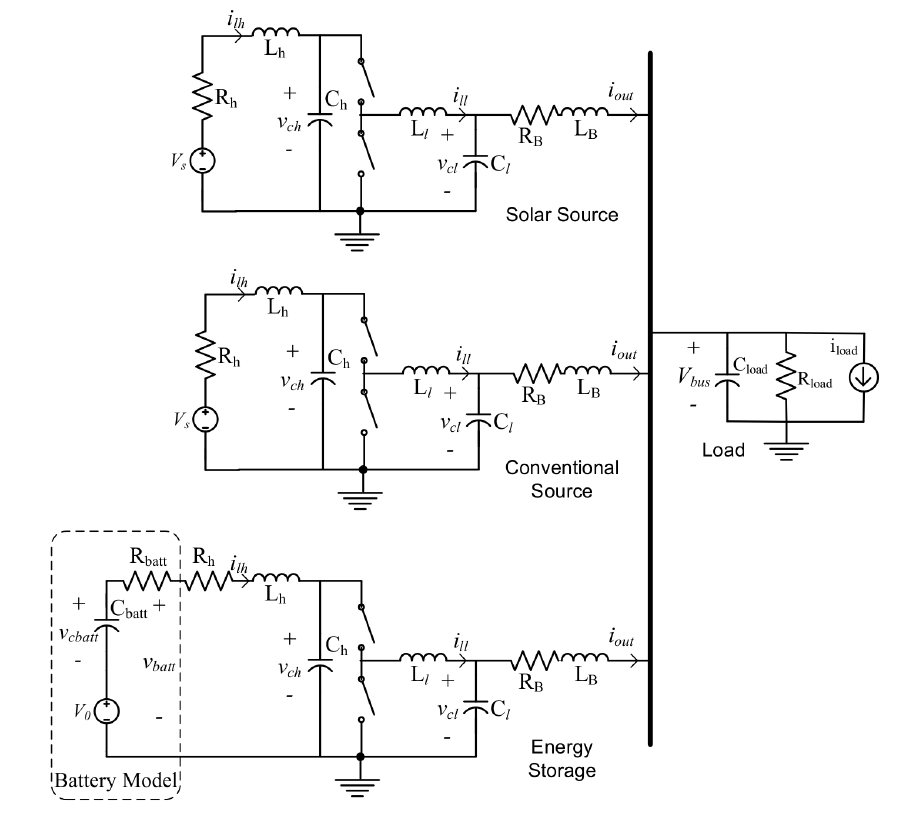
Figure 8. Example microgrid used in hardware-in-the-loop (HIL) for PB demonstration of droop control methods.